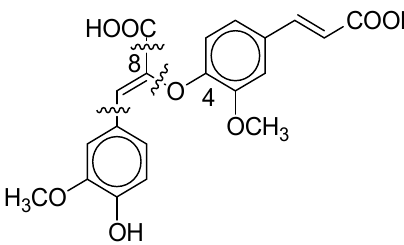
/ MS fragmentation sites.